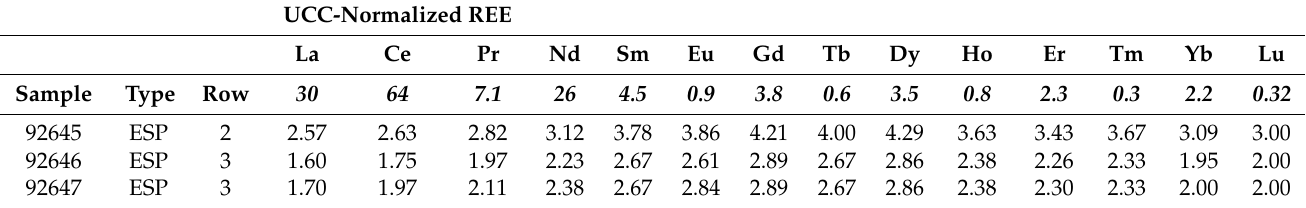
Table 5. Upper continental crust-normalized rare earth